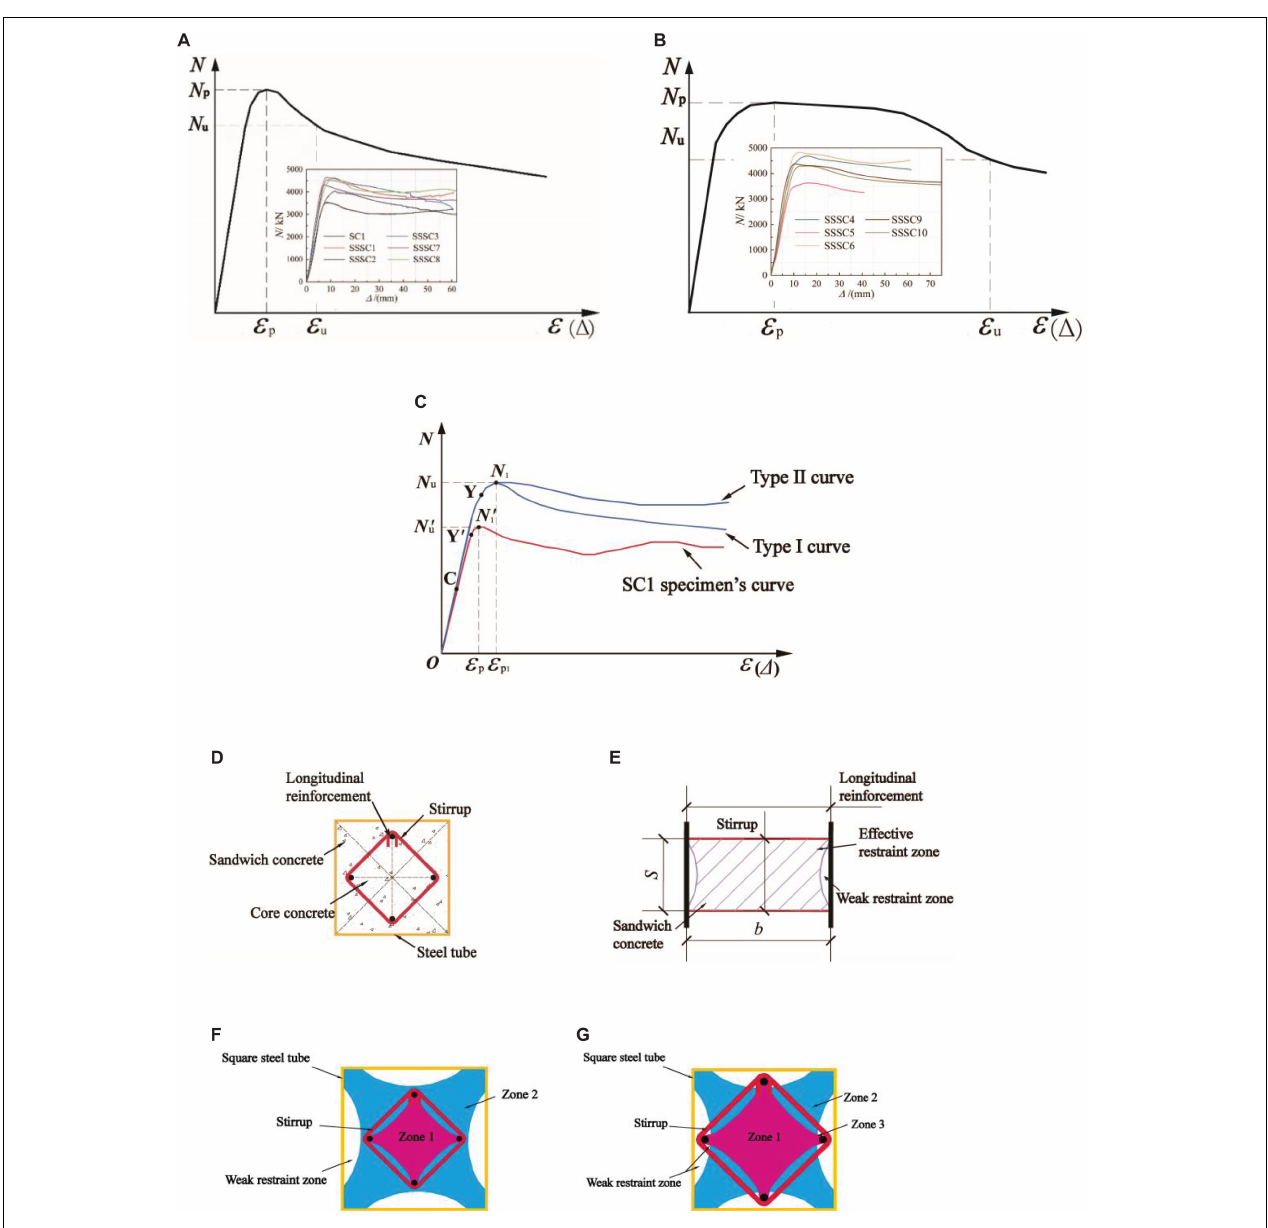
FIGURE 5 | Mechanism analysis. (A) Type I curve. (B) Type II curve. (C) Comparison of load-displacement curves. (D) Sandwich concrete at cross-section. (E) Longitudinal sandwich concrete and its effective constraint distribution. (F) The first type of constraint mode. (G) The second type of constraint